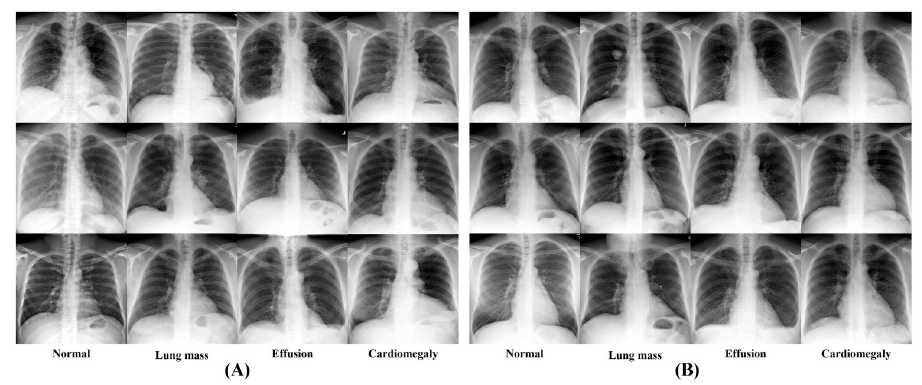
Fig 3. (A) Real images and (B) GAN-generated images.